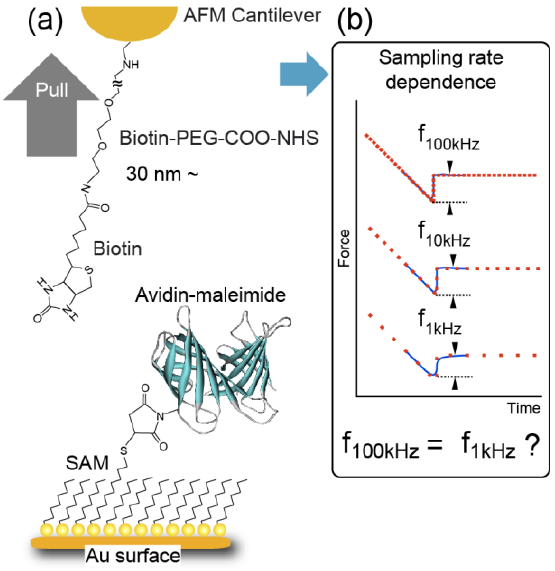
Figure 2. Schematic illustrations of the method of sample preparation and the effect of sampling rate on force curve